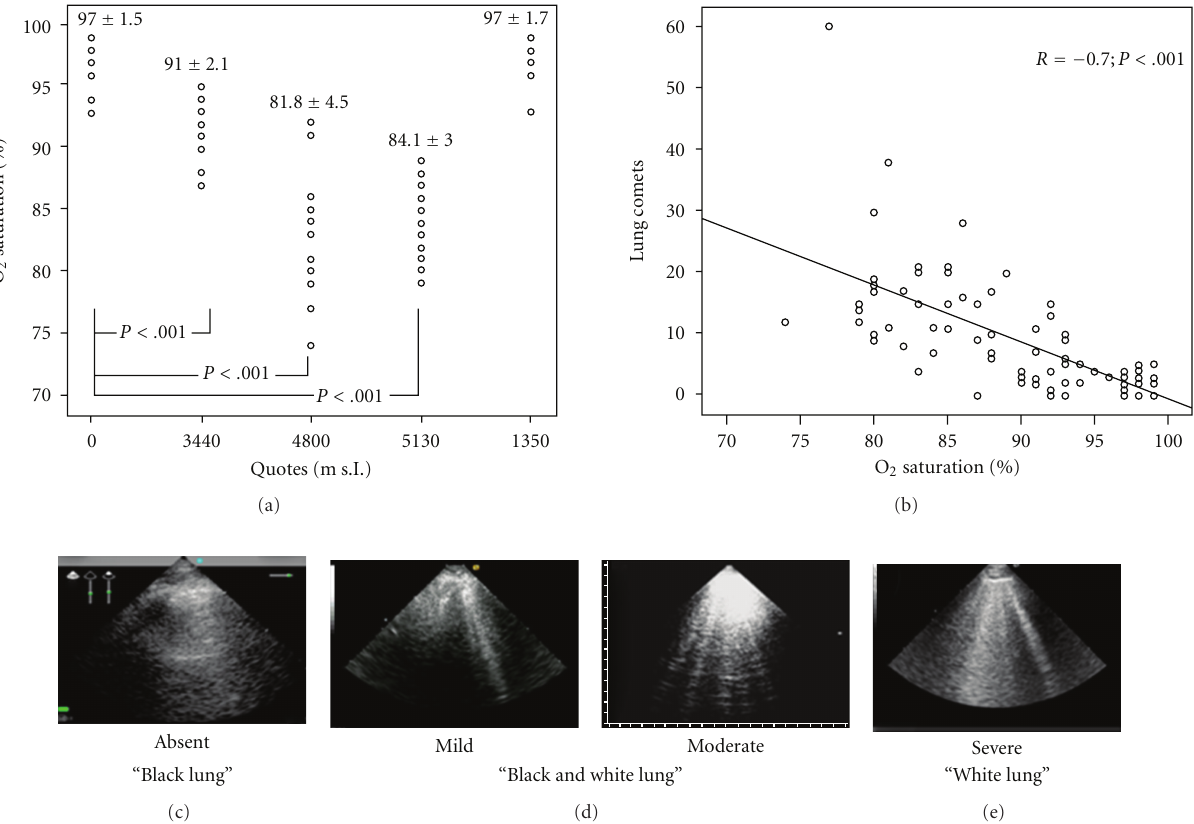
Figure 2: Progressive O 2 saturation reduction at increasing altitude above sea level. Inverse correlation between O 2 saturation and lung comets. Increase number of ULCs from sea level to 5130 meters above sea level (Pratali et al. [64]).